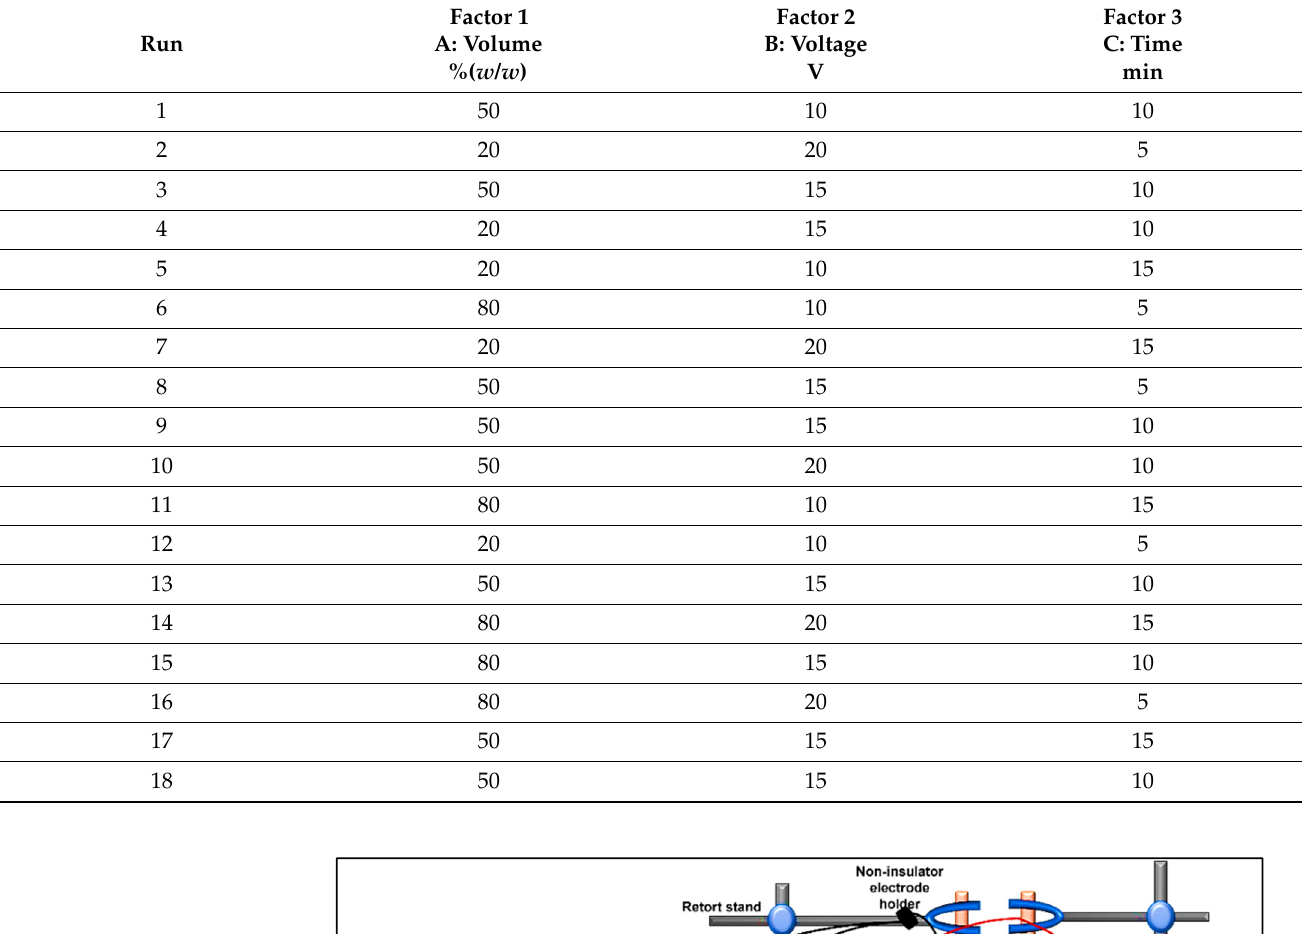
Table 4. Experimental design for a 20% and 80% water volume ratio.